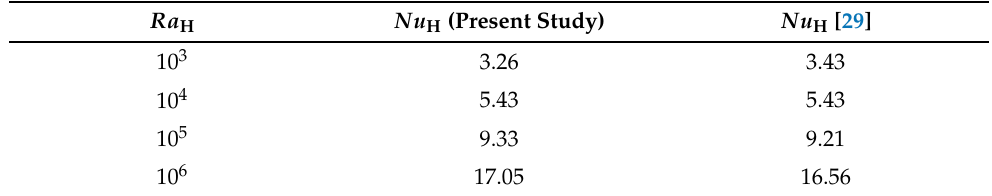
Figure 2. Comparison between present numerical data and Bar-Choen and Rohsenow correlation [5] for two vertical parallel plates suspended in free air. Table 3. Comparison between the present numerical data and the predictions of the Churchill-Chu correlation [29] for a heated vertical plate suspended in free air.